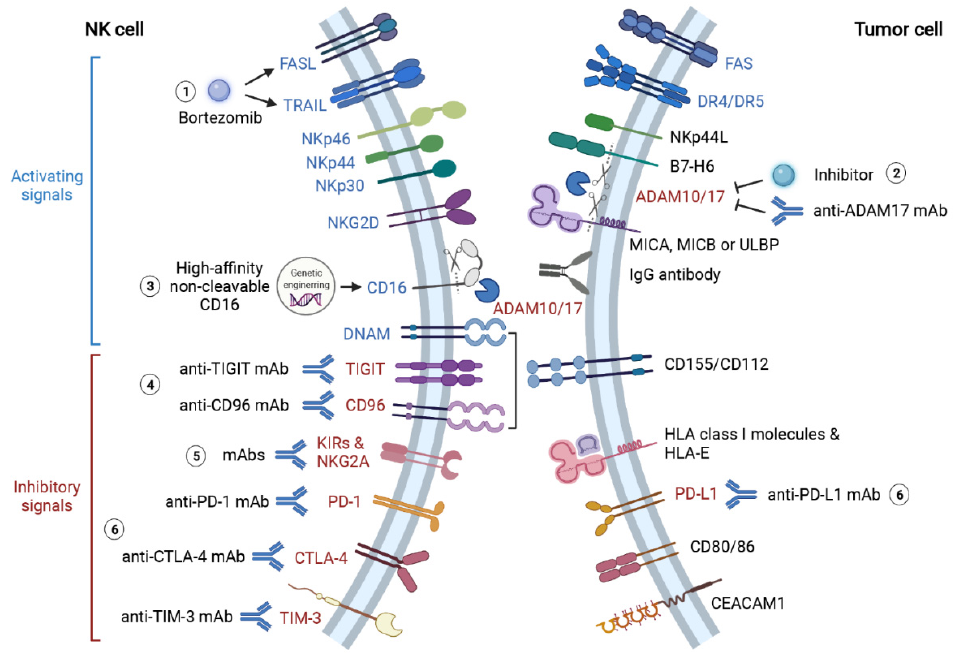
Figure 2. Summary of therapeutic approaches to reinforce NK recognition and activation in solid tumor microenvironment. TME blunts NK recognition of tumor cells via diverse mechanisms. The key mediators of these mechanisms represent promising therapeutic targets to restore NK recognition and activation. ( 1 ) Proteasome inhibitor bortezomib augments NK anti-cancer effects by enhancing TRAIL- and FasL-mediated cytotoxicity. ( 2 ) NK recognition of tumor antigens is significantly hampered by protease ADAM10- and ADAM17-mediated shedding of CD16, B7-H6 and NKG2DL (MICA, MICB and ULBP). Thereby, treatments of anti-ADAM17 mAb and ADAM inhibitors can promote NK recognition and activation via CD16, NKp30 and NKG2D. ( 3 ) Additionally, the genetic-engineered “off-the-shelf” NK with high-affinity non-cleavable CD16 (FT516) is also resistant to protease-mediated cleavage, and its therapeutic effect is now being tested in clinical trials. ( 4 ) Activating receptor DNAM competes for ligands CD155 and CD112 with inhibitory receptors TIGIT and CD96. Monoclonal antibody therapies targeting TIGIT and CD96 effectively inhibit cancer progression and metastasis by preventing TIGIT- and CD96-induced NK exhaustion. ( 5 ) KIRs and NKG2A play crucial roles in the “missing self” mechanism of NK cells. However, tumor cells take advantage of this mechanism to evade NK-mediated immunosurveillance. Blocking these inhibitory signals with monoclonal antibodies also restores NK cytotoxicity against tumor cells. ( 6 ) Immune checkpoint molecules PD-1, PD-L1, CTLA-4 and TIM-3 induce NK cell exhaustion when they bind to corresponding ligands on tumor cells. ICIs targeting these molecules largely enhance NK recognition and cytotoxicity against tumor cells. This figure is created with